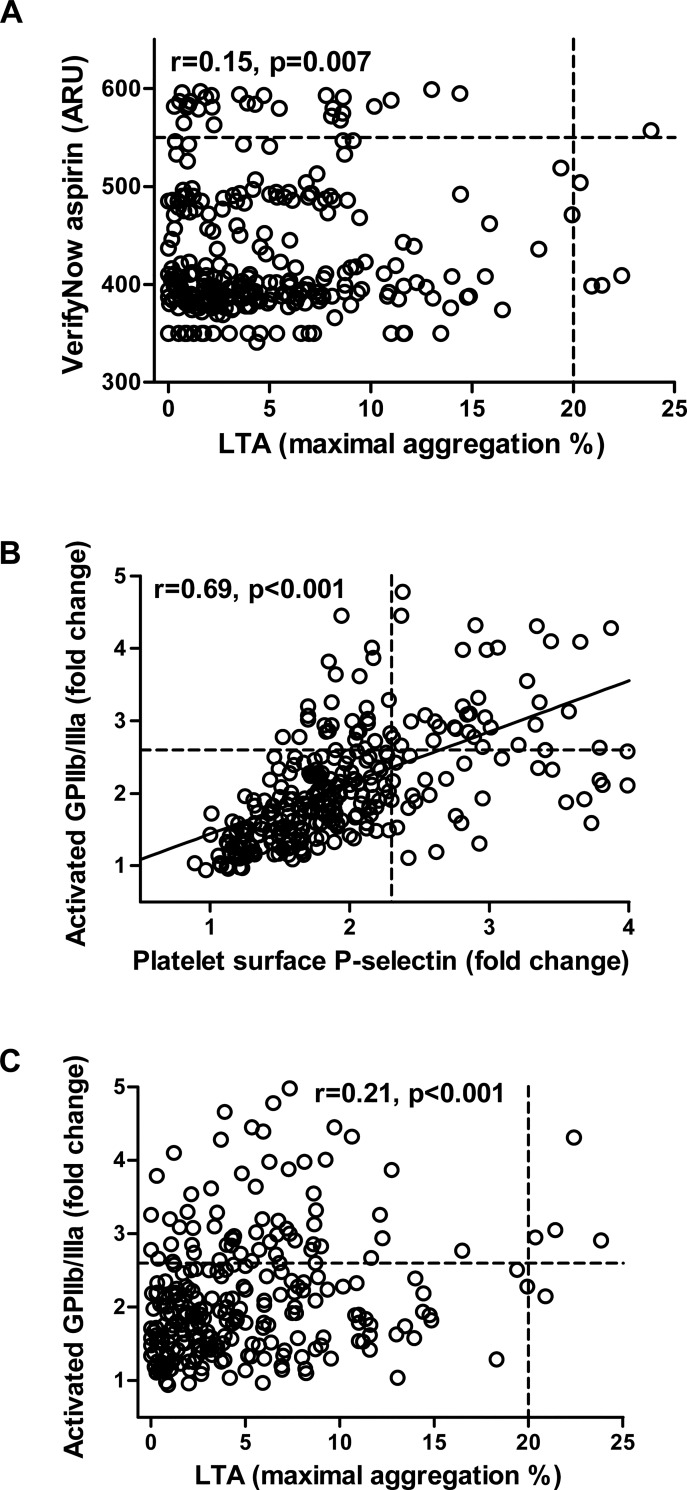
Correlations of arachidonic acid (AA)-induced platelet aggregation and platelet activation.
(A) Scatter plot showing AA-induced platelet reactivity by light transmission aggregometry (LTA; x-axis) vs. platelet reactivity by the VerifyNow aspirin assay (y-axis). Circles represent individual measurements. Cut-off values for high on-treatment residual platelet reactivity are indicated by the dotted lines. ARU, Aspirin Reaction Units. (B) Scatter plot showing AA-induced platelet surface P-selectin expression (x-axis) vs. AA-induced activated glycoprotein (GP) IIb/IIIa (y-axis). Circles represent individual measurements. Cut-off values for high P-selectin and high GPIIb/IIIa are indicated by the dotted lines. (C) Scatter plot showing AA-induced platelet reactivity by light transmission aggregometry (LTA; x-axis) vs. AA-induced activated glycoprotein (GP) IIb/IIIa (y-axis). Circles represent individual measurements. Cut-off values for high on-treatment residual platelet reactivity and high GPIIb/IIIa are indicated by the dotted lines. ARU, Aspirin Reaction Units.